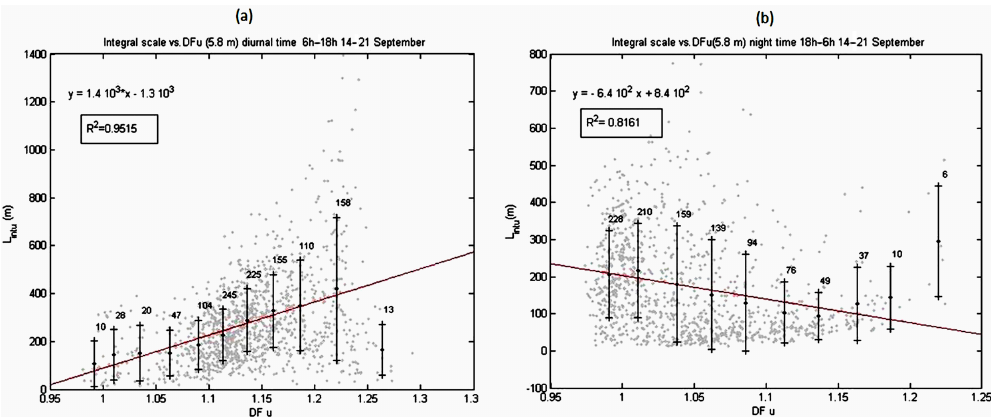
Figure 5. Variations of the integral scale vs. the fractal dimension of the u (cid:48) component of the wind velocity at 5.8m. (a) Diurnal hours 06:00– 18:00; (b) night hours 18:00–06:00. On the top left of each graph is indicated the linear regression of the average values (a) L intu (5.8m) = 1 . 4 × 10 3 DF u (5.8m) − 1 . 3 × 10 3 and (b) L intu (5.8m) = − 6 . 4 × 10 2 DF u (5.8m) + 8 . 4 × 10 2 , L intu and DF u being the integral scale and fractal dimension for the u component,